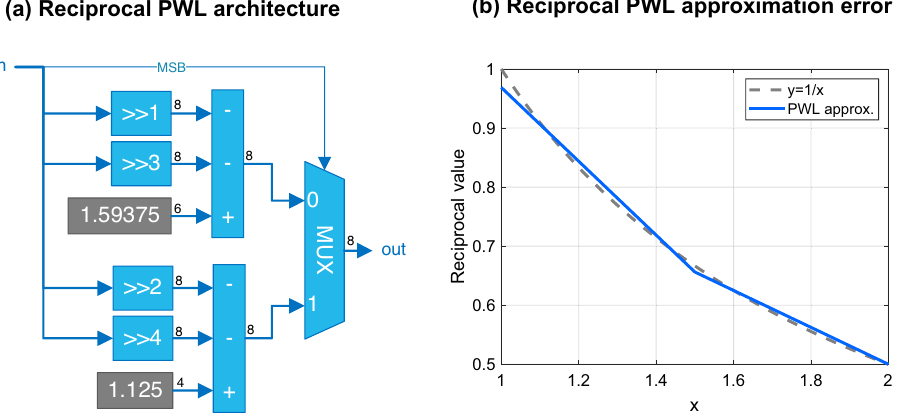
Figure 4. ( a ) Architecture of the PWL reciprocal block. ( b ) PWL reciprocal function for x in the range